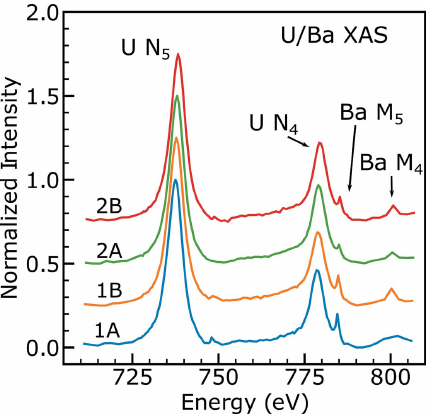
Figure 8 A comparison of U spectra on four different FIB sections in the sample. 1A and 1B are located on the rim of the pellet, and 2A and 2B are located near the center. Each spectrum is normalized to a U N 5 peak intensity of 1. Spectra are offset by 0.25 for clarity.